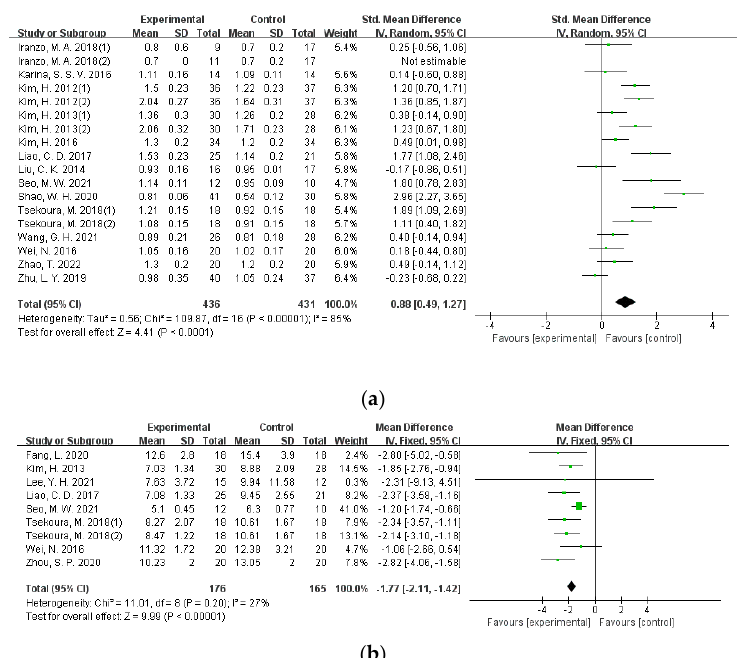
Figure 6. Forest plot for physical performance. ( a ) Forest plot of the effectiveness of exercise interventions for walking speed improvement in older adults with sarcopenia; ( b ) forest plot of the effectiveness of exercise interventions for functional mobility improvement in older adults with sarcopenia.